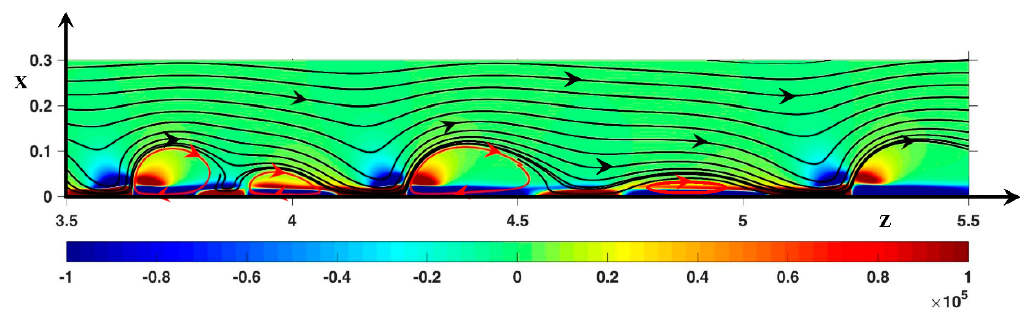
→  ( ) Tot F Tot ) F . Black lines: static streamlines. ΔΦ = 23, 3 1 3 10 ν − = × , 1 D z . Black lines: static streamlines. z